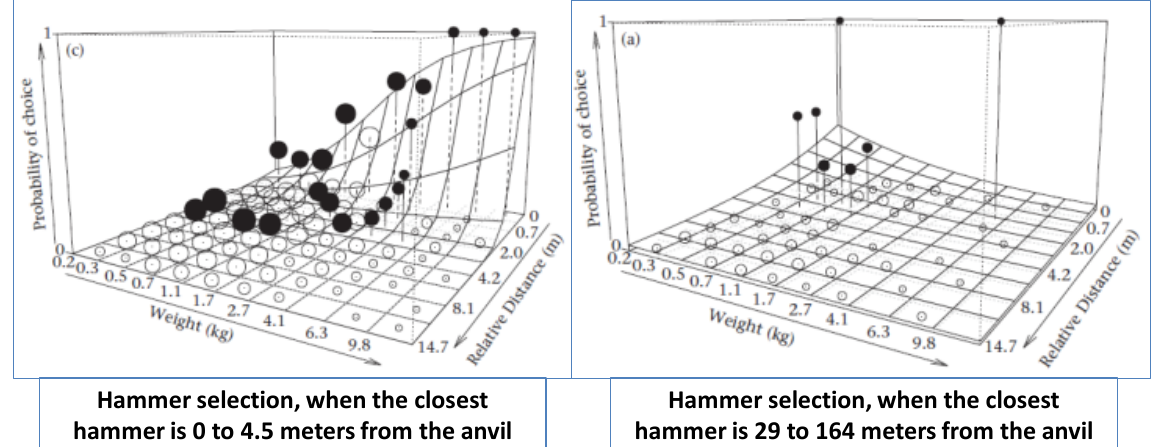
Hammer Weight Selection in Taï Chimpanzees for Coula Nuts According to the Transport Distance